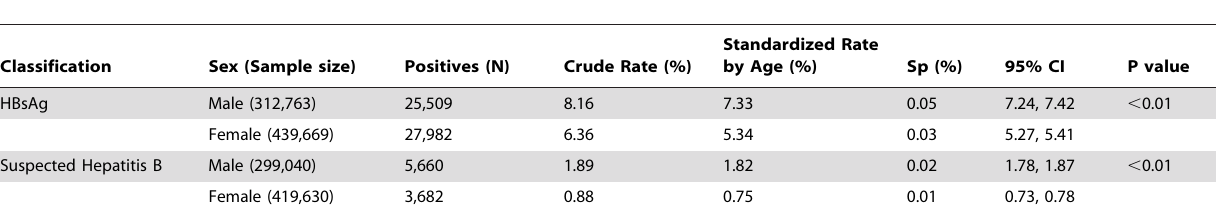
Table 1. HBsAg carrier rate and prevalence of suspected hepatitis Bin male and female